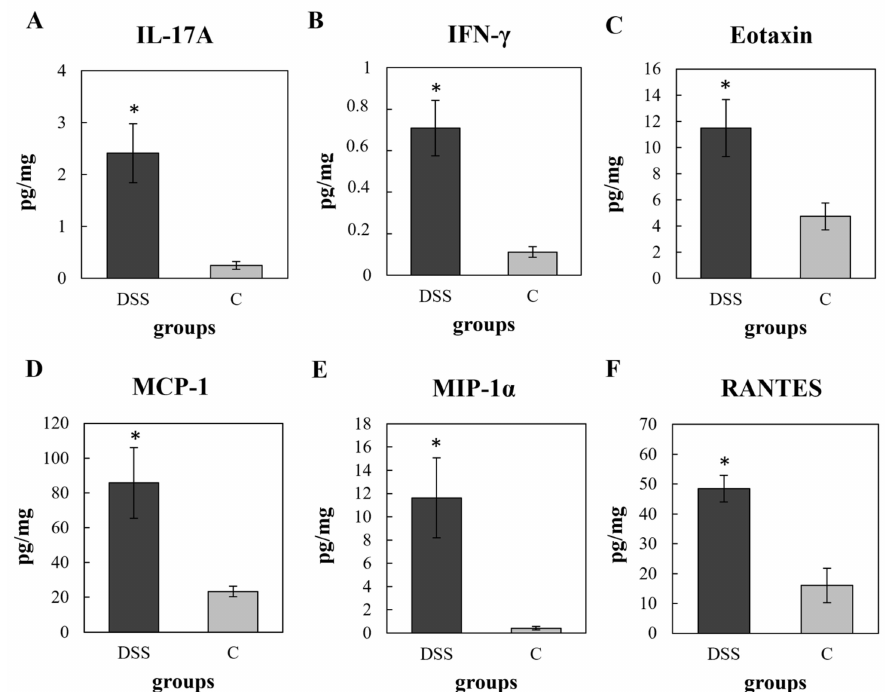
Figure 5. Significantly increased levels of pro-inflammatory cytokines: IL-17A ( A ); IFN- γ ( B ) and chemokines: eotaxin ( C ); MCP-1 ( D ); MIP-1 α ( E ) and RANTES ( F ) in the colon tissue of DSS group. Data are expressed as mean ± SEM ( n = 16/DSS group; n = 6/C group); (* p < 0.05). DSS, induced colitis; C, healthy control. MCP-1, monocyte chemoattractant protein-1; MIP-1 α , macrophage inflam- matory protein 1-alpha; RANTES, regulated on activation, normal T-cell expressed and